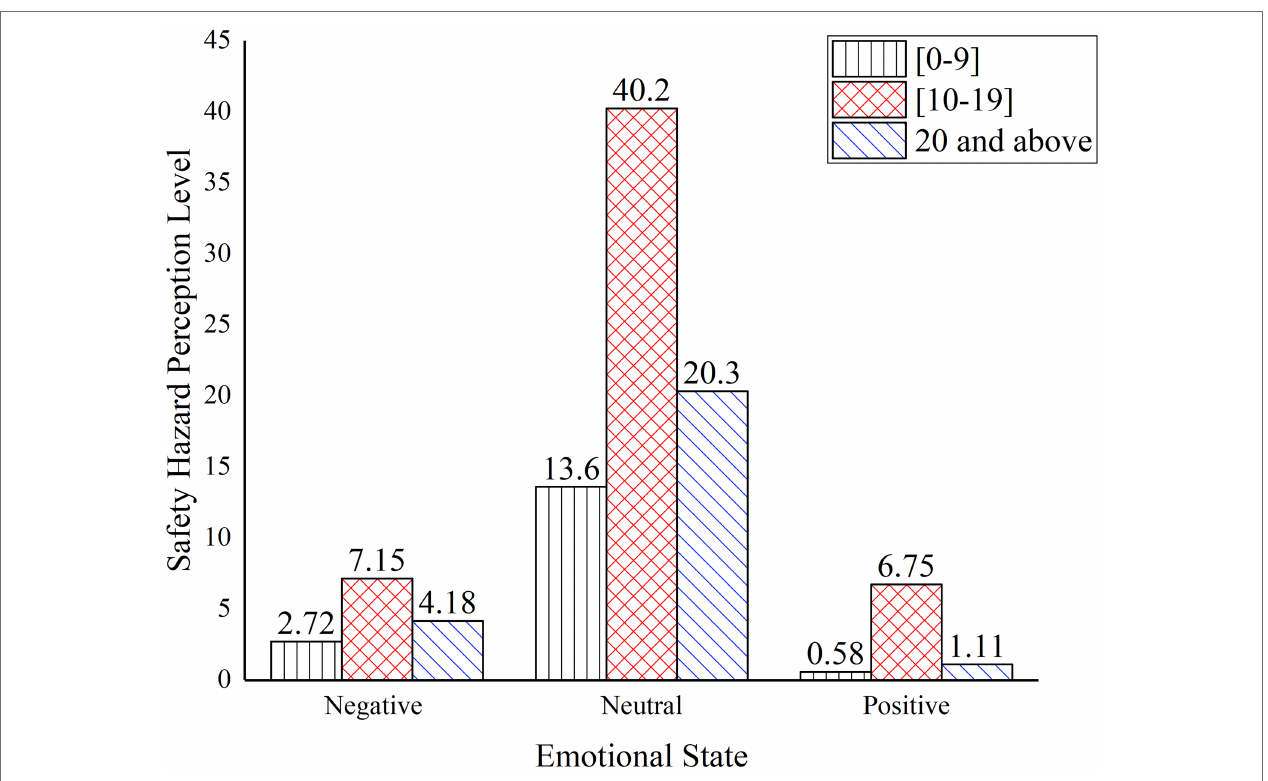
FIGURE 8 | Perception level of safety hazard under different working ages.